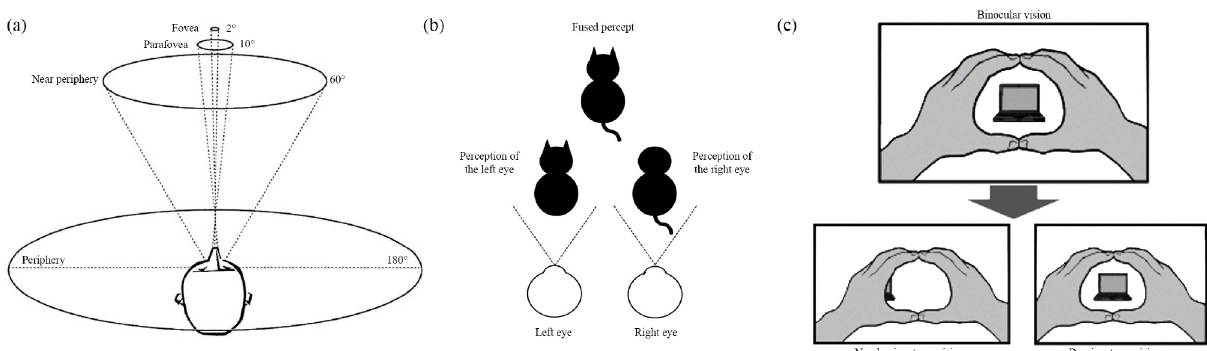
Fig. 1 (a) Schematic illustration of foveal \ peripheral vision from Ivanˇci´c Valenko et al. [41]. The eccentric angle of the foveal region is very small, while the eccentric angle of the parafoveal region is up to 10 ◦ . The eccentric angle of the near peripheral region is about 60 ◦ and that of the peripheral region area is 180 ◦ . (b) Schematic illustration of fusional vision from Schaadt [42]. Two laterally placed eyes provide us two horizontally shifted and disparate images of the visual scene, which are continuously integrated into a single percept. (c) Schematic illustration of dominant eye. Compared with the nondominant eye, the dominant eye contributes more to the binocular vision. Reproduced with permission from Ref. [41], c (cid:13) Portal hrvatskih znanstvenih i struˇcnih ˇcsopisa–Hrˇcak 2019; Ref. [42], c (cid:13) Universit¨at des Saarlandes